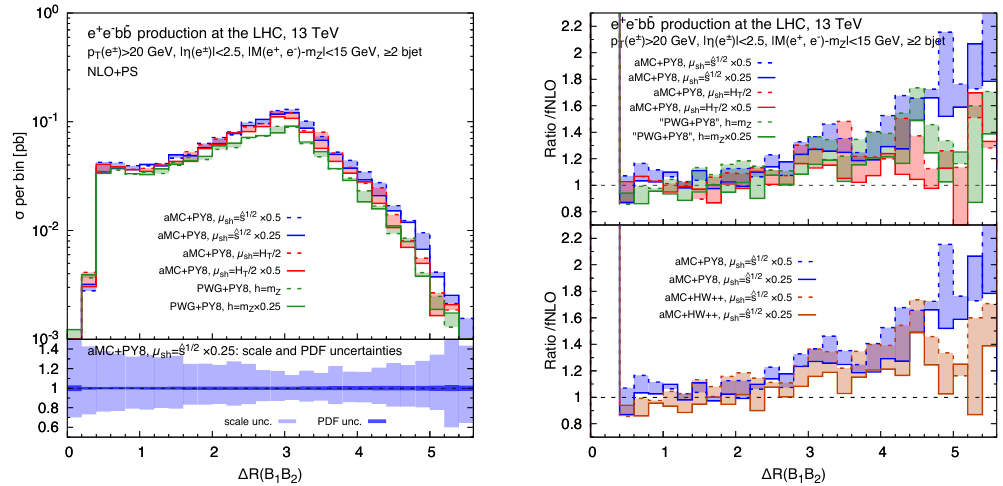
Figure 26 . (cid:1) R distribution of the B hadrons pair in association with at least 2 b jets.